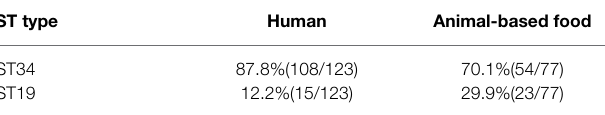
TABLE 1 | Multi-locus sequence typing (MLST) of different of Salmonella Typhimurium isolates from human- and animal source food. ST type